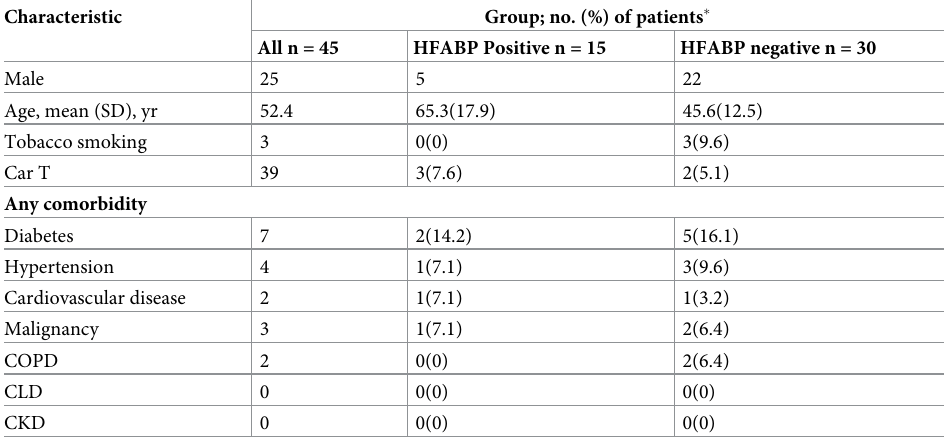
Table 1. Demographic and disease characteristics of enrolled patients. Characteristic Group; no. (%) of patients � All n = 45 HFABP Positive n = 15 HFABP negative n = 30 Male 25 5 22 Age, mean (SD), yr 52.4 65.3(17.9) 45.6(12.5) Tobacco smoking 3 0(0) 3(9.6) Car T 39 3(7.6) 2(5.1) Any comorbidity Diabetes 7 2(14.2) 5(16.1) Hypertension 4 1(7.1) 3(9.6) Cardiovascular disease 2 1(7.1) 1(3.2) Malignancy 3 1(7.1) 2(6.4) COPD 2 0(0) 2(6.4) CLD 0 0(0) 0(0) CKD 0 0(0) 0(0) Chronic obstructive pulmonary disease = COPD, Chronic liver disease = CLD, Chronic kidney disease = CKD, Cardiac troponin T = Ca T. Note: All differences were statistically nonsignificant. SD = standard deviation. � Except as indicated for